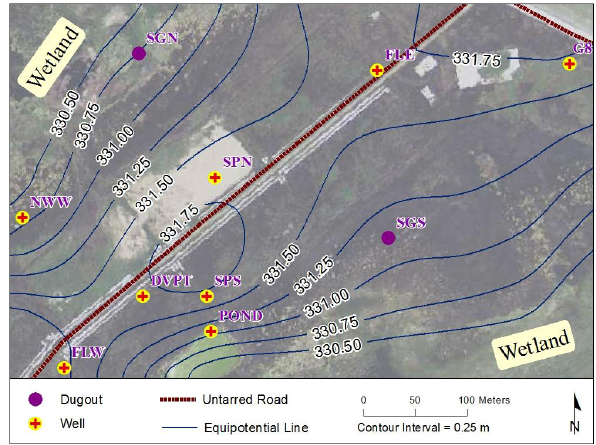
Fig. 2. Potentiometric map showing the lateral flow of groundwater Figure 2. Potentiometric map showing the lateral flow of groundwater toward wetlands in the toward wetlands in the northwest and southeast (fall 2010). northwest and southeast (fall 2010).